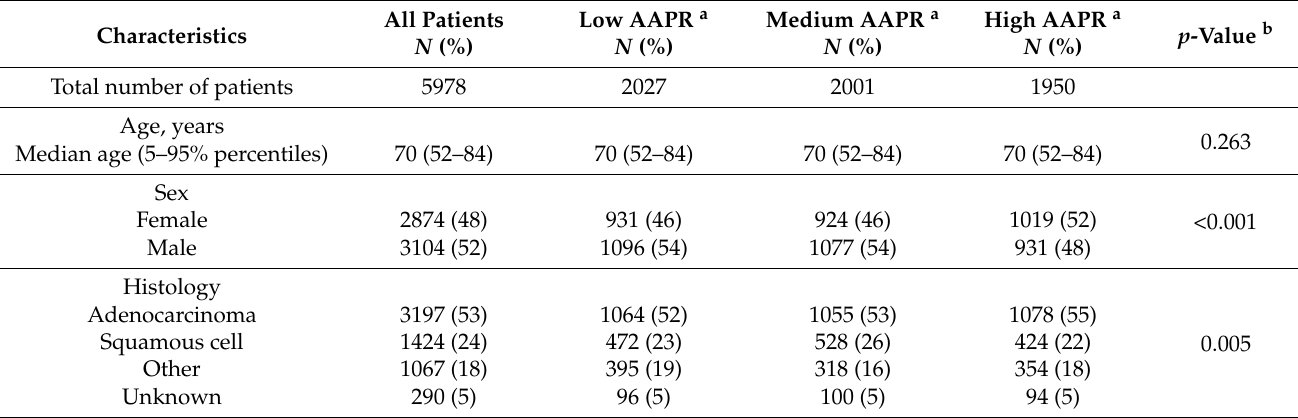
Table 1. Patient characteristics in non-small cell lung cancer patients stratified by albumin-to-alkaline phosphatase ratio at time of diagnosis ( N =